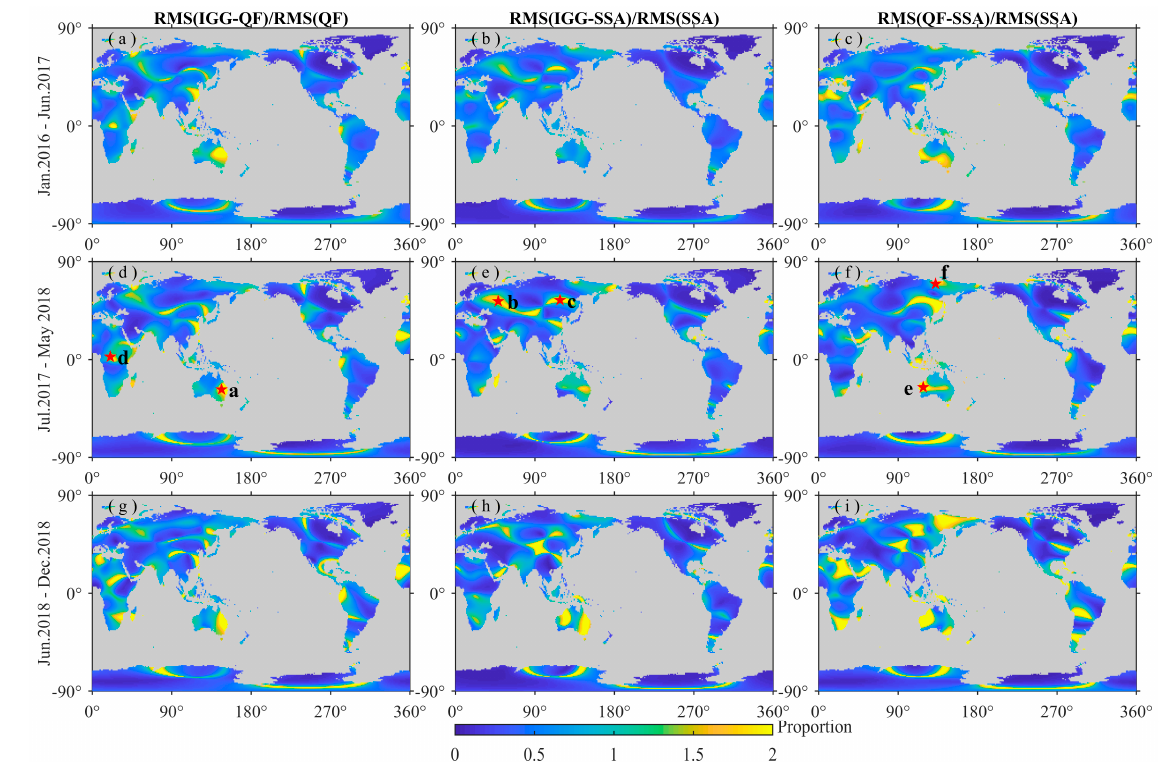
Figure 5. Worldwide comparison of the SSA, IGG, and QF results during ( a – c ) January 2016 to June 2017, ( d – f ) July 2017 to May 2018, and ( g – i ) June 2018 to December 2018. Plotted are the rRMS values of IGG relative to QF (subplots ( a , d , g )), IGG relative to SSA (subplots ( b , e , h )) and QF relative to SSA (subplots ( c , f , i )).